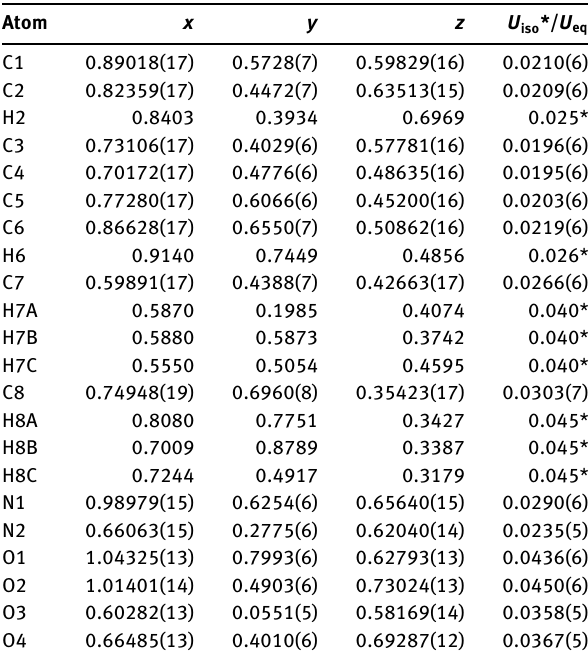
Table 2: Fractional atomic coordinates and isotropic or equivalent isotropic displacement parameters (Å 2